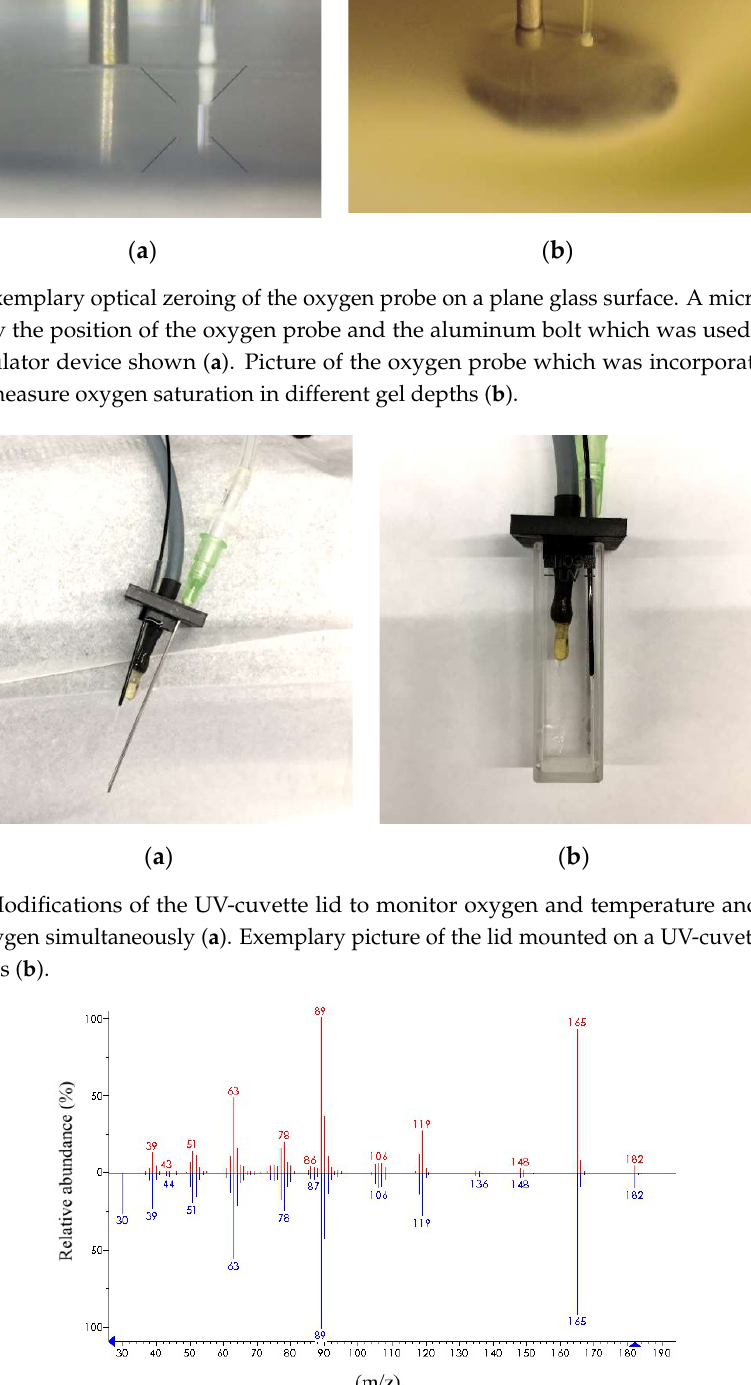
Figure A4. Mass to charge spectrum of 2,4-dinitrotoluene at a retention time of 24.7 min detected with TDS silicone twisters and GC-MS.